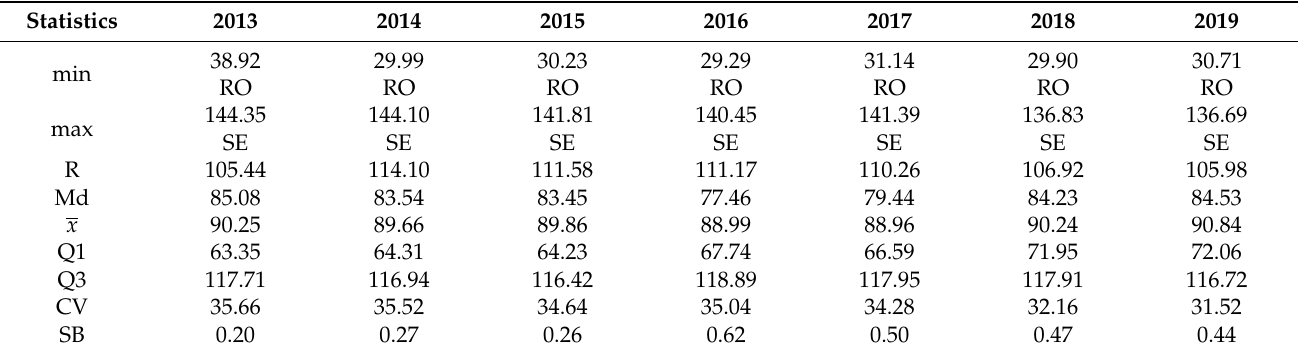
Table 2. Descriptive parameters of the Summary Innovation Index value for the European Union countries in the years 2013–2019 (EU average =